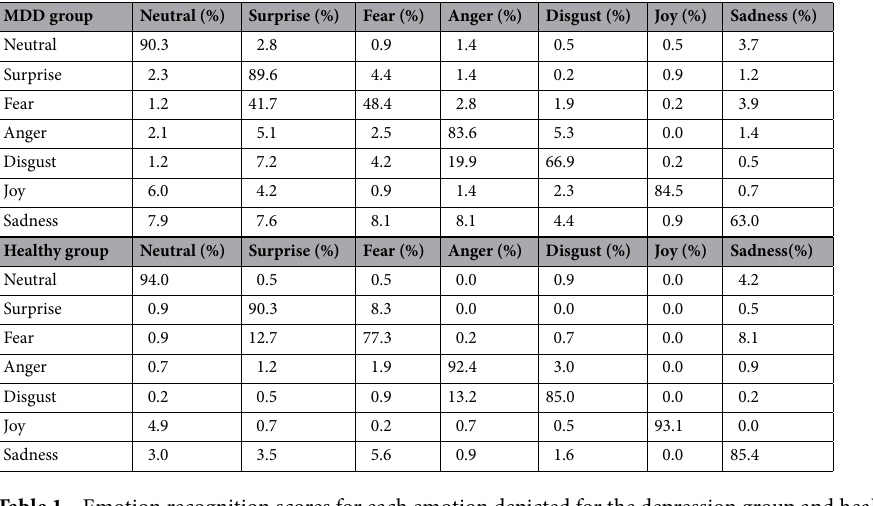
Table 1. Emotion recognition scores for each emotion depicted for the depression group and healthy controls. Columns: recognized emotions. Rows: displayed